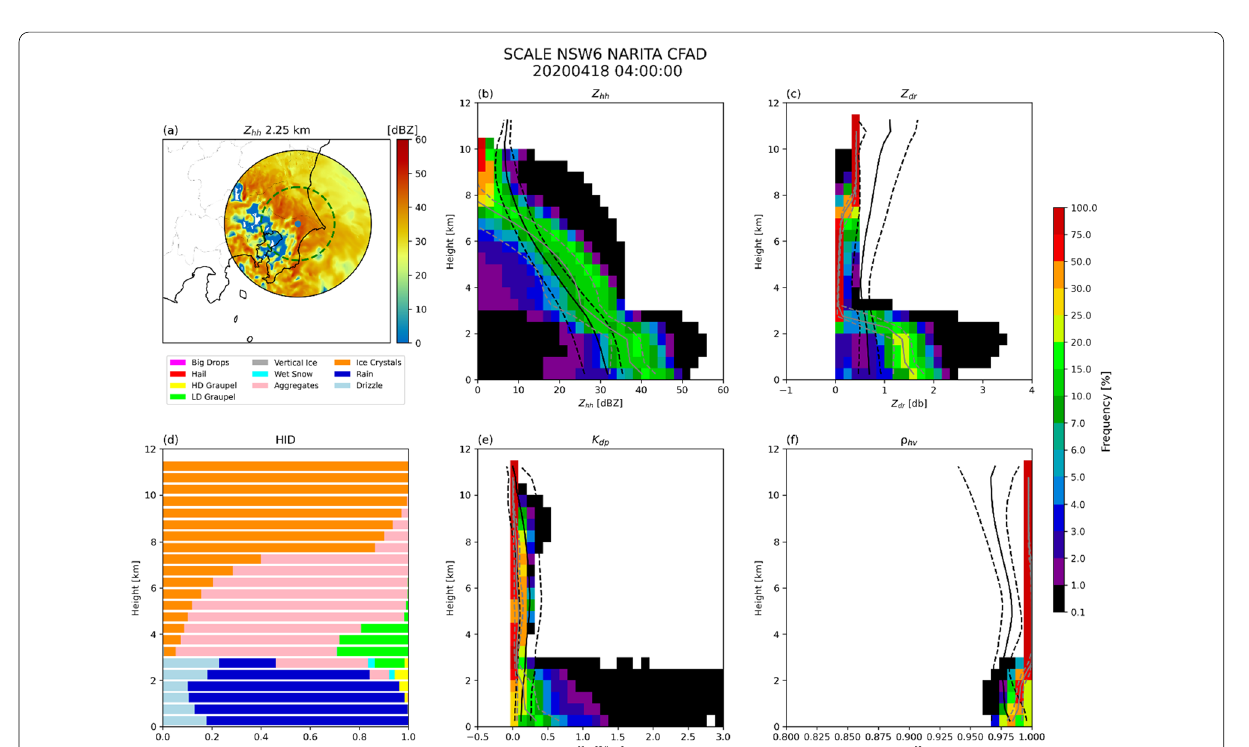
Fig. 23 The same as Fig. 10, but for the SCALE-NDW6 simulation